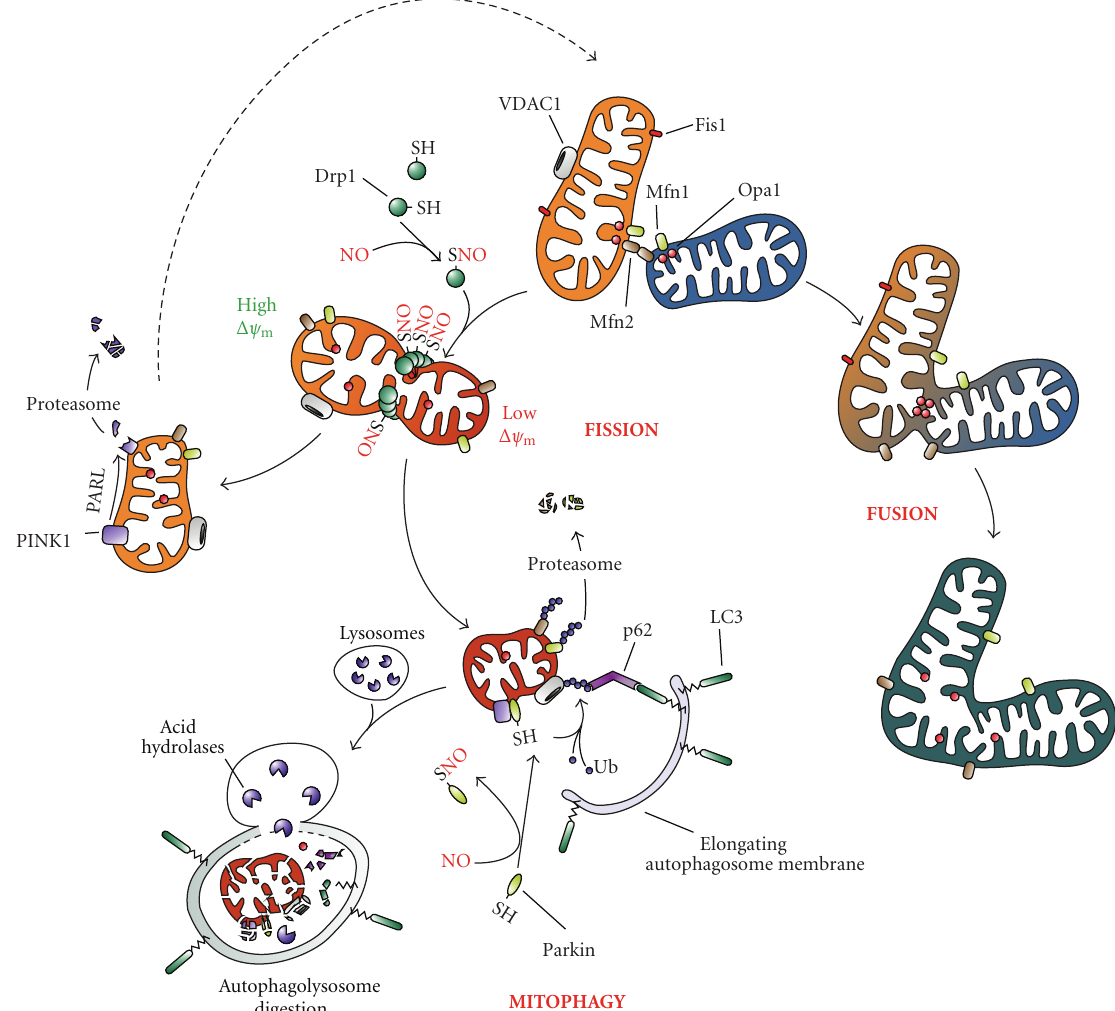
Figure 4: E ff ects of NO on mitochondrial dynamics and mitophagy. Mitochondrial network is dynamically regulated by fusion/fission events. Fusion between adjacent mitochondria (on the right) relies on the activity of Mfn1, Mfn2, and Opa1 which act in concert to mediate the merge of the outer and inner membrane, respectively. Although the presence of S -nitrosylated Opa1 has been observed, no role for this modification has been still proposed. Conversely, Drp1 has been reported to undergo several posttranslational modifications which modulate its fission activity (on the left), such as phosphorylation (not shown in the figure) and S -nitrosylation. Once S -nitrosylated and driven by mitochondria depolarization (low ΔΨ m ), Drp1 is recruited onto the outer mitochondrial membrane by means of the recognition of its anchor protein Fis1. There, SNO-Drp1 multimerizes and acts to tighten the target organelle in order to share the depolarized portion from the healthy part. Although there is the possibility for a fragmented mitochondrion to refuse by means of Mfns and Opa1-mediated activity, frequently a depolarized organelle is targeted for its selective removal by autophagy (mitophagy). PINK1, which is normally degraded by PARL, is stabilized and recruits Parkin onto the outer membrane of an impaired mitochondrion and, in turn, catalyzes the covalent addition of an ubiquitin (Ub) tail to several protein targets. Ubiquitinated Mfns are extracted from the membrane and degraded via the proteasome in order to inhibit refusion processes, whereas ubiquitination of VDAC1 is required for mitochondria to be recognized and embedded by p62/LC3-bound autophagosome and ultimately degraded by lysosome-contained acid hydrolases. Parkin can undergo S -nitrosylation- mediated inactivation of its ubiquitin E3 ligase activity, thereby inhibiting mitophagy and disbalancing fusion/fission